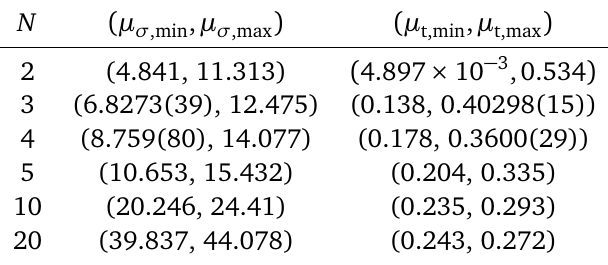
Table 4: Bounds on the boundary OPE coefficients from the positive bootstrap.